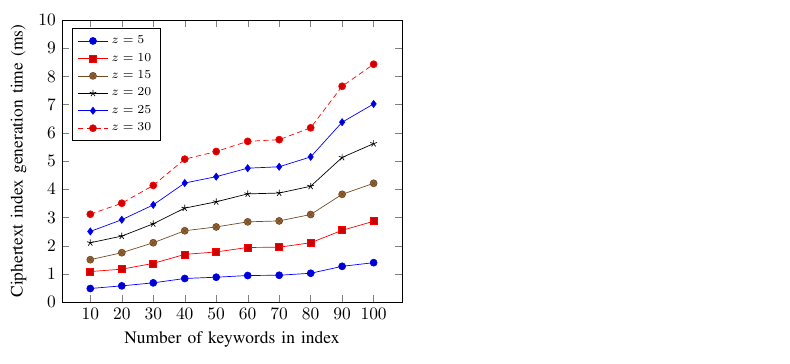
Figure 7. Time cost on ciphertext index generation for multiple types of keywords by the extended PRMS scheme.